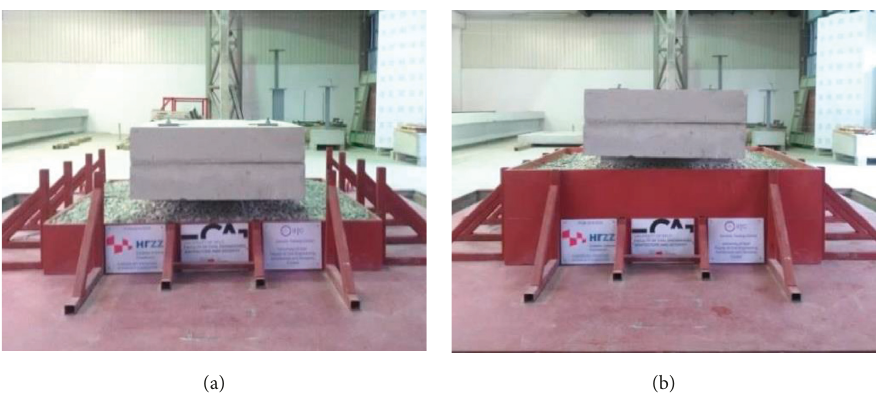
Figure 9: Photos of experimental setup before testing. (a) Pebble layer h